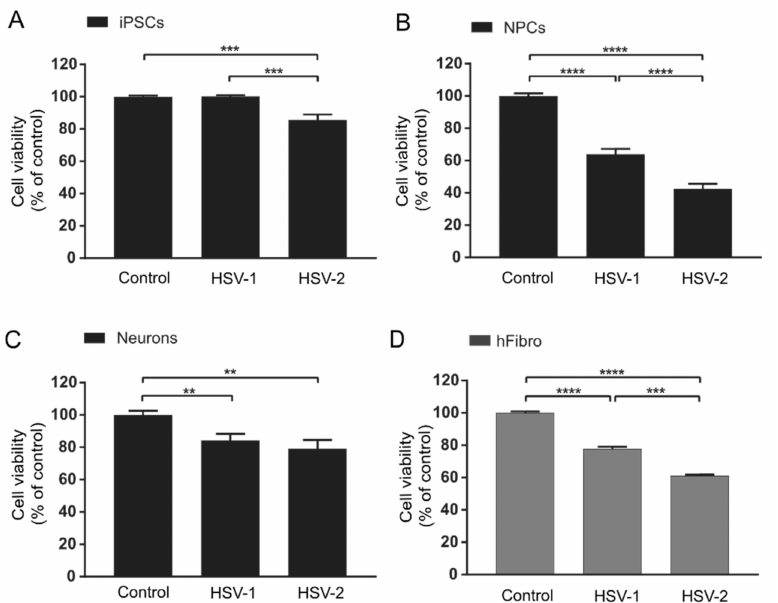
Figure 4. Viability of cells infected with herpes simplex virus (HSV) 1 and 2 at three stages during neuronal differentiation measured 48 h post-infection at MOI = 0.1. ( A ) HSV-1 infection does not affect the cell viability of iPSCs, while HSV-2 infection reduces cell viability of iPSCs by 14.6% compared with non-infected control iPSCs. Bars represent mean of six separate experiments on two iPSC lines +/ − SEM. ( B ) HSV-1 and HSV-2 infections reduce cell viability of NPCs by 36.0% and 57.6%, respectively, compared with non-infected control NPCs. Bars represent mean of five separate differentiations from two iPSC lines +/ − SEM. ( C ) Neuron viability is slightly reduced 48 h after infection (15.8% and 20.8% by HSV-1 and HSV-2, respectively). No significant difference in cytopathic effect is observed between HSV-1 and HSV-2 in neurons. Bars represent mean of four separate differentiations on two iPSC lines +/ − SEM. Viability of human fibroblasts ( D ) infected with herpes simplex virus (HSV) 1 and 2 measured 48 h post-infection at MOI = 0.1. Bars represent mean of three separate experiments +/ − SEM. ** p < 0.01, *** p < 0.001 and **** p < 0.0001 from Student’s t